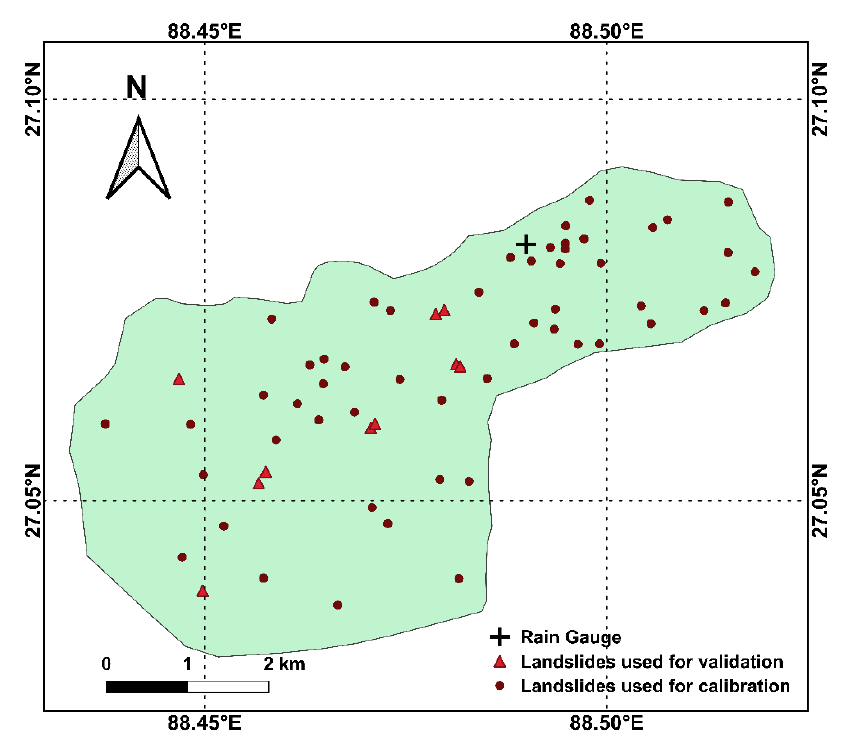
Figure 3. Spatial distribution of rain gauges and landslide events during the study period. (modified after [15]).